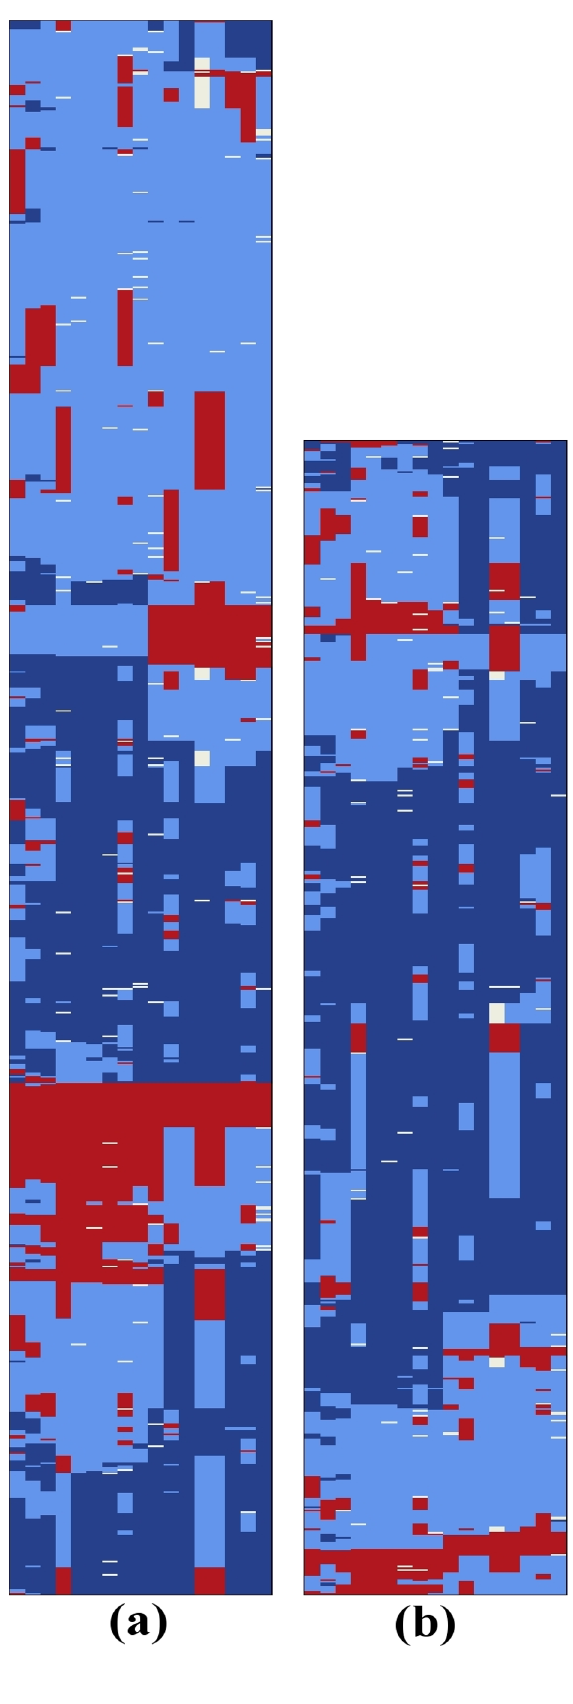
Figure 3. Genotype states of (a) 929 psoriatic cases and (b) 681 controls for bloc ps_1 . (Best viewed in color.) Each row represents an individual and each column represents a SNP. Dark blue represents a homozygote for the protective allele, light blue represents a heterozygote, red represents a homozygote for the risk allele, and white indicates missing data. Individuals (rows) were rearranged using TSP + k [77] in order to place similar individuals near each other and enhance visualization of